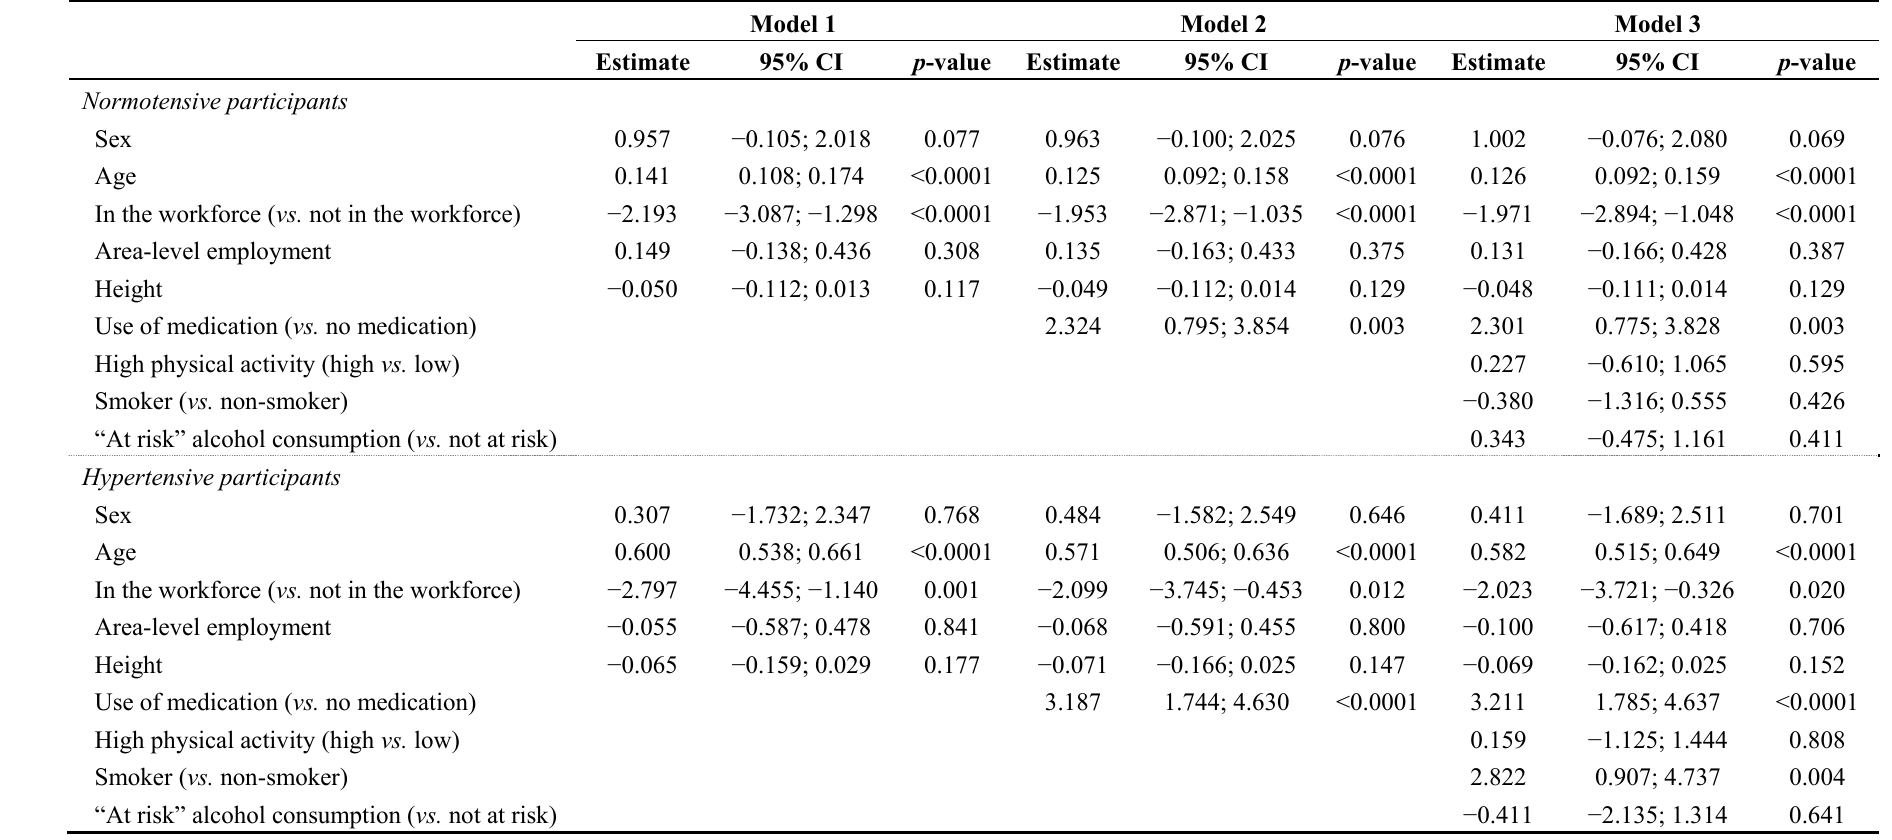
Table 4. Results of models testing the associations between pulse pressure and employment status, according to hypertensive